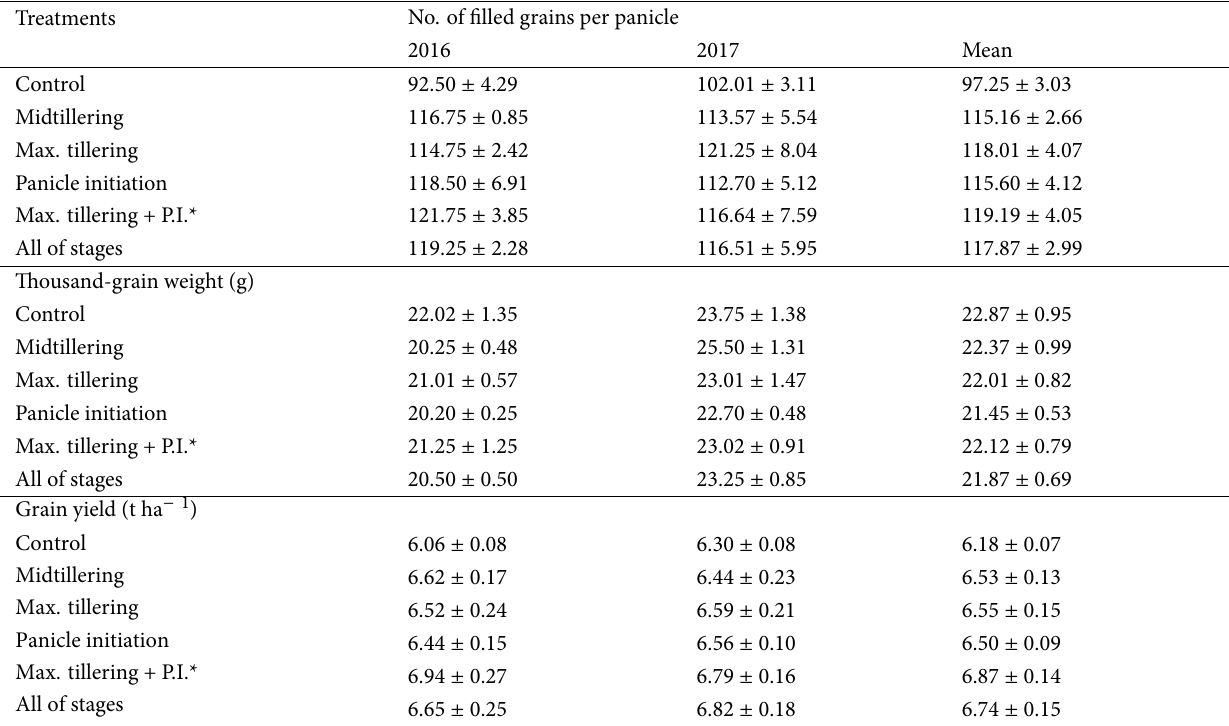
Table 2 Mean comparison of foliar application of nutrients on the traits of number of filled grains per panicle, 1,000-seed weight, and grain